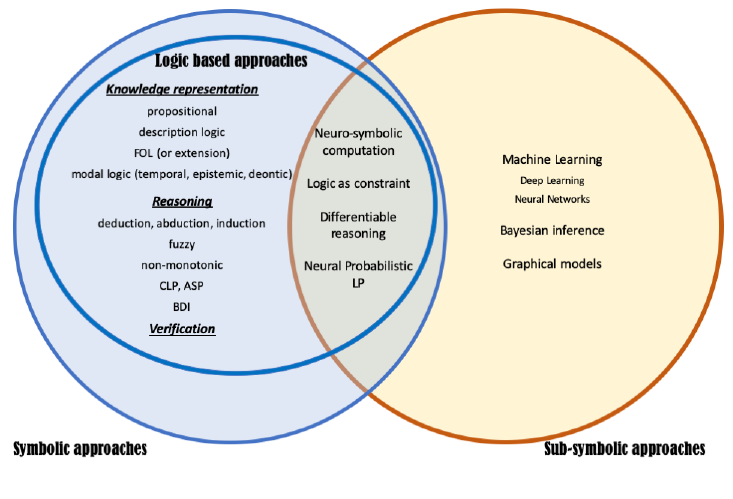
Figure 1. A graphical view of symbolic and sub-symbolic approaches highlighting the role of logic-based technologies along with their main